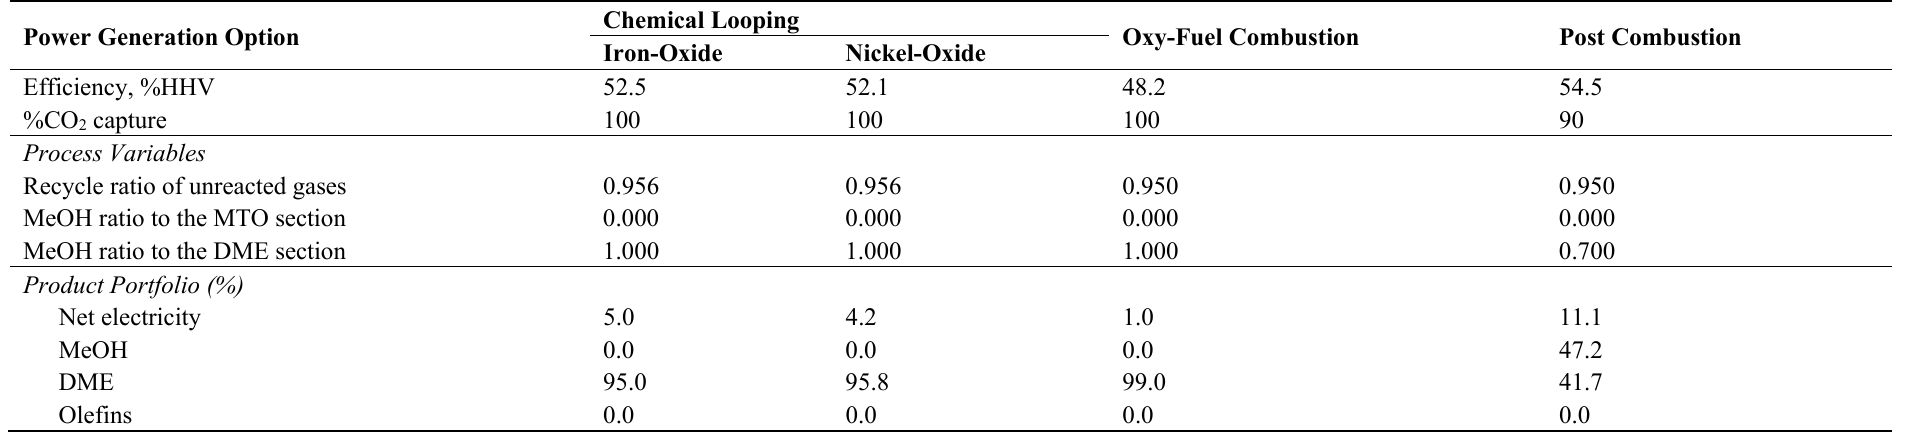
Table 7. Comparison of the power generation options using Fayetteville shale gas (maximum DME production).